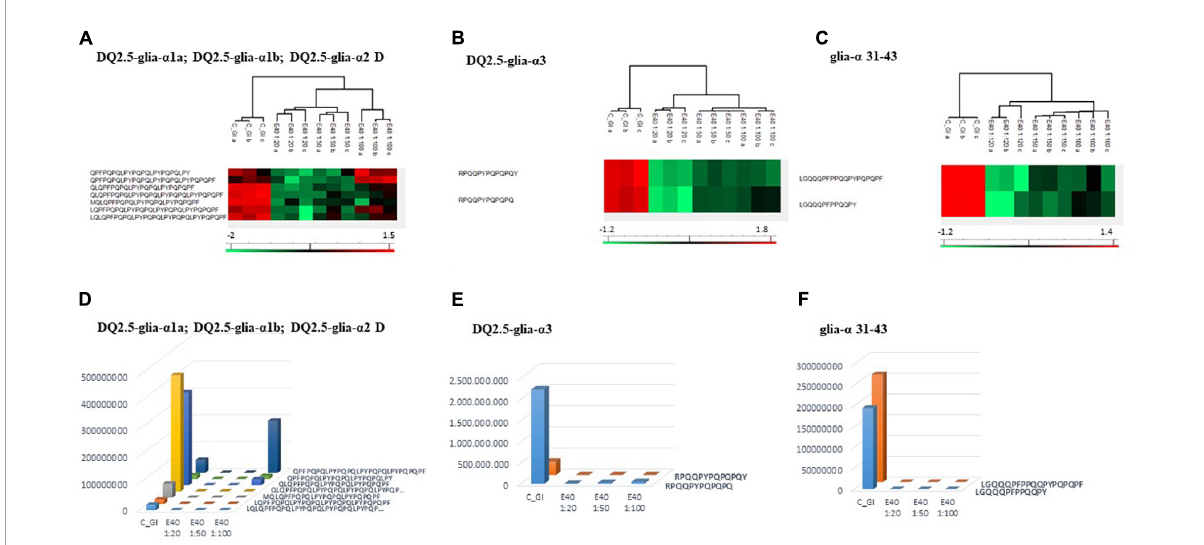
FIGURE5 Residual intestinal immunogenic alpha-gliadin CeD sequences in bread control (GI) and digesta at dose-dependent E40 detoxification (1:20, 1:50 and 1:100). (A–C) Heatmap of LC-MS/MS analysis of the proteases resistant peptides harboring alpha-gliadin CeD epitopes, of the technical replicates of Control (GI) and E40 glutenase groups; the red color represents high-resistant, and the green color represents low-resistant gluten peptides; values are scaled across columns, generating column z-scores. (D–F) Graphical representation of the sum (average value of technical triplicates) of LC-MS/MS intensity of peptides harboring CeD alpha-gliadin epitopes identified in control (GI) and E40 (1:20, 1:50, and 1:100) treated bread sample.